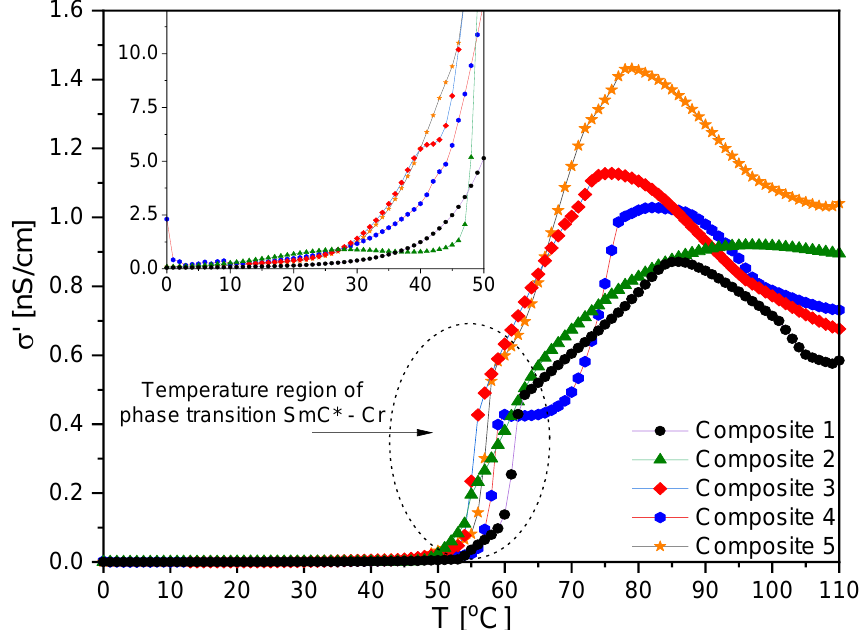
Figure 14. Temperature dependencies of the real part of specific electric conductivity for Composites 1 – 5 registered at 10.5